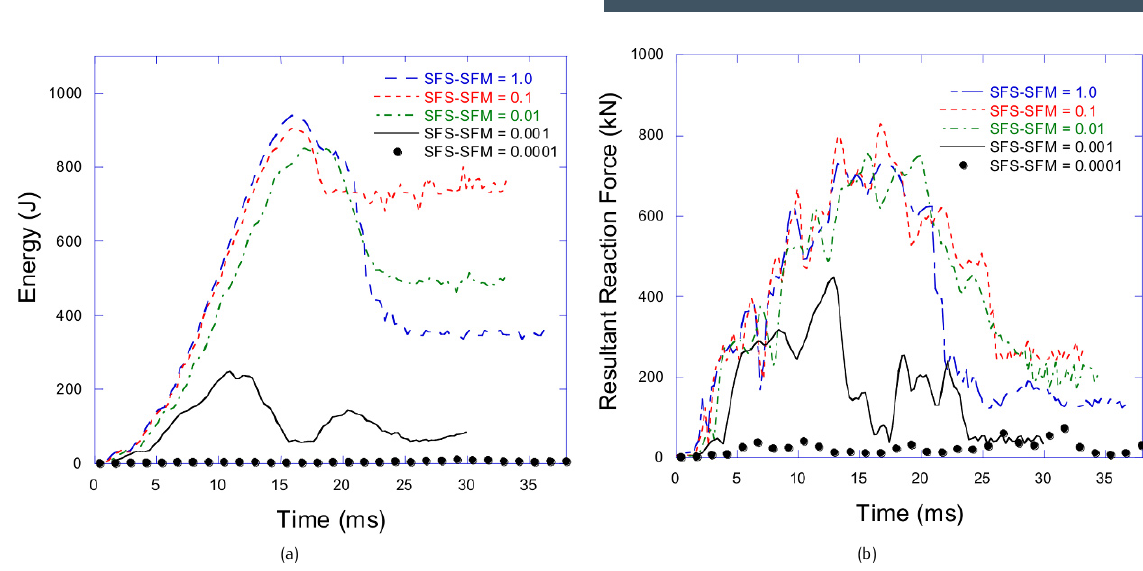
Figure 11. Comparison of absorbed energy of the impacted plate modelled with 1 shell (24 integration points) with different SFS/SFM values.